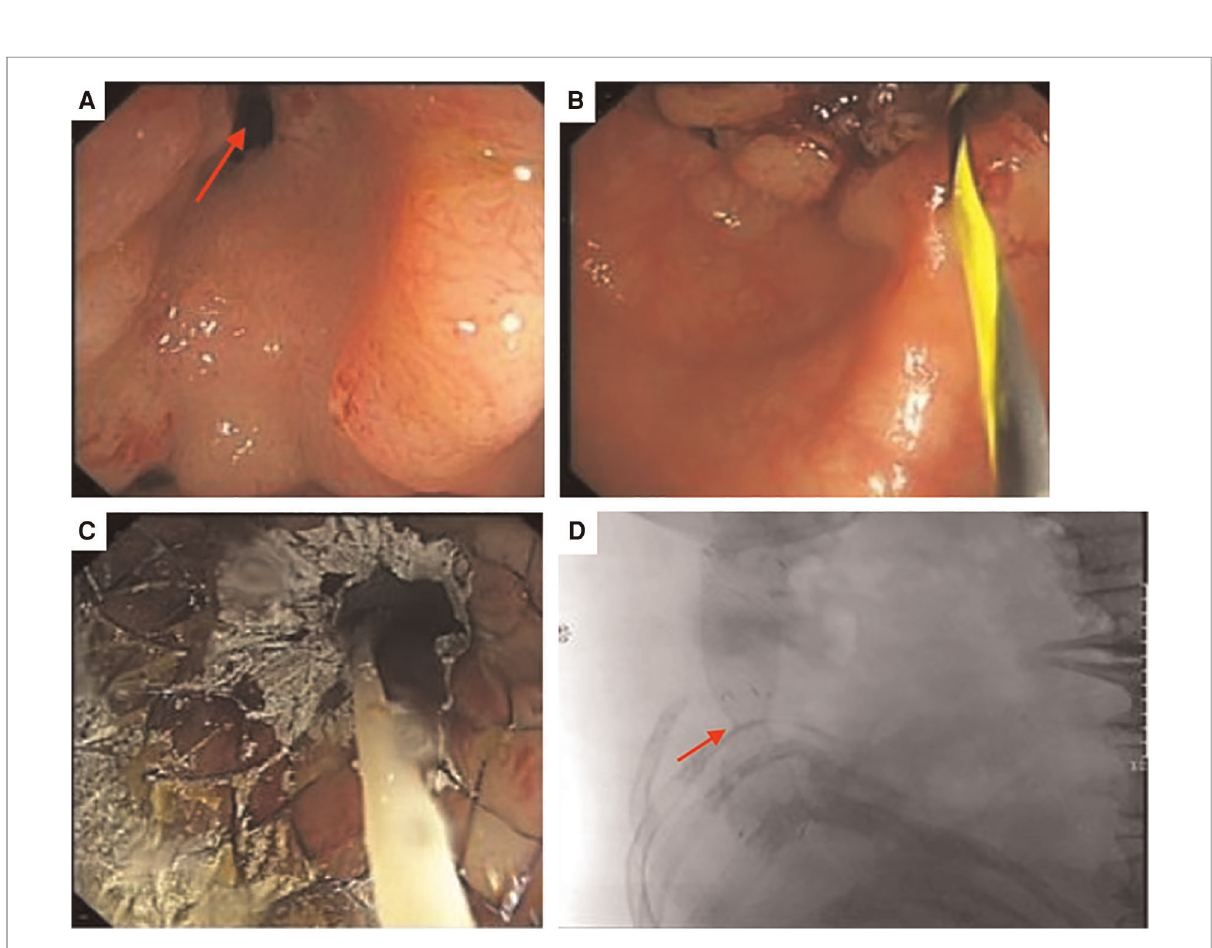
FIGURE 2 ( A ) Endoscopy revealing a narrowed intestinal lumen (red arrow). ( B ) Prior to placement of SEMS ( C ) successful stent placement relieving intestinal obstruction ( D ) x-ray showing location of stent and signi fi cant relief of intestinal